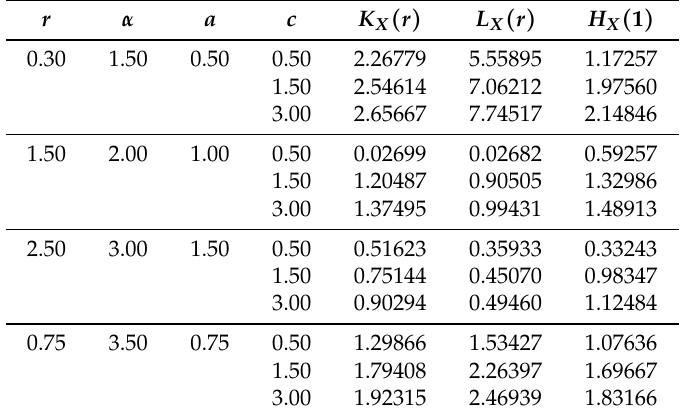
Table 1. Numerical values of Rényi, Tsallis, and Shannon entropies for the APExE distribution. r